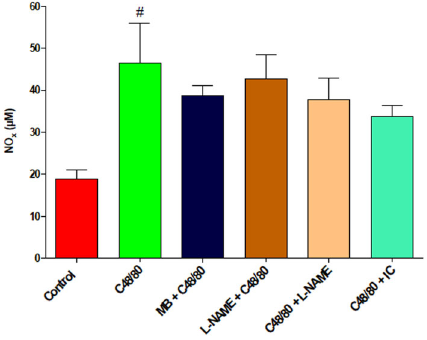
Figure 6. Plasma nitric oxide (NO) analysis of all groups. Data are reported as mean ± SE. # P o 0.01 compared to control (one-way ANOVA and Bonferroni post -test). MB: methylene blue; L-NAME: N o -nitro-L-arginine methyl ester hydrochloride; IC: indigo